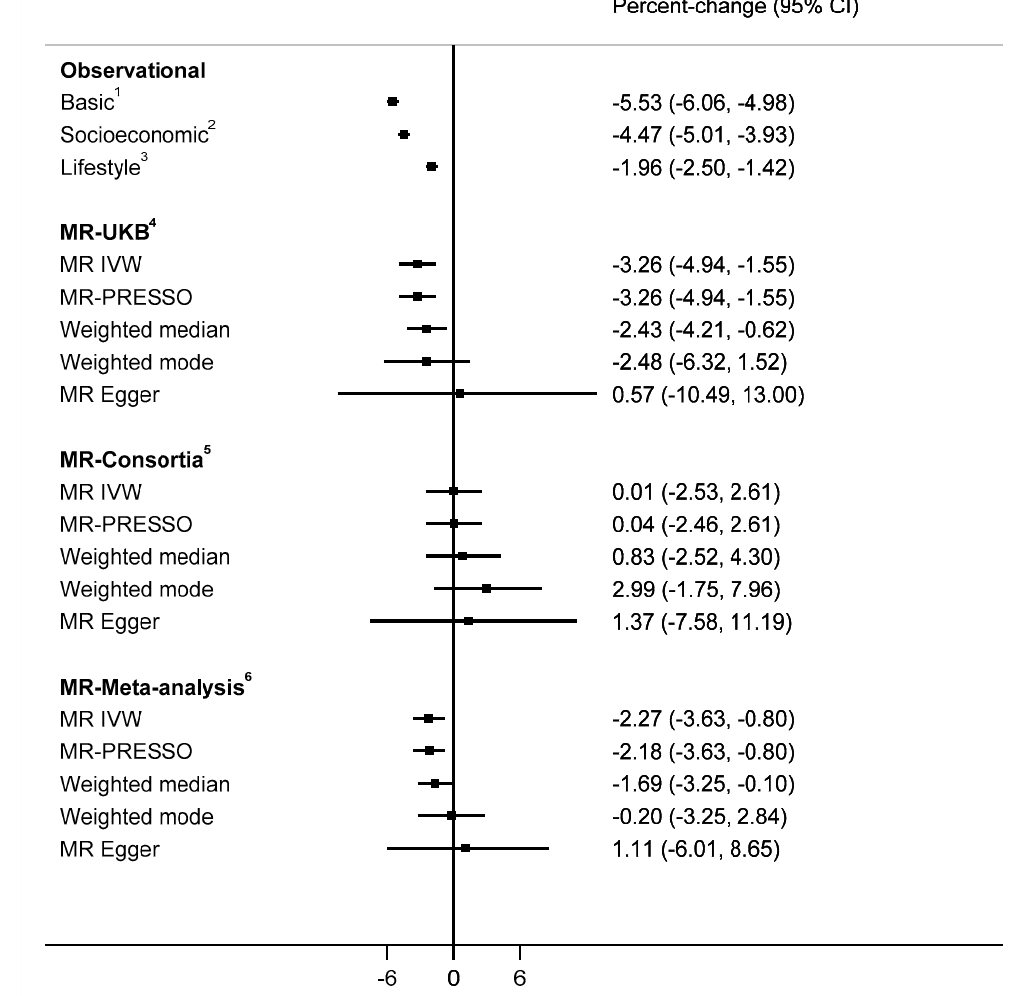
Figure 3. Observational and MR analyses on the association between depression and 25(OH)D concentrations. 1 Basic model included adjustment for basic covariates including age, sex, assessment centre and date of blood sample collected. 2 Socioeconomic model included adjustment for basic and socioeconomic-related covariates including education, Townsend deprivation index and employment. 3 Lifestyle model included adjustment for basic, socioeconomic and lifestyle-related covariates including smoking, alcohol consumption, BMI, physical activity, fish and cheese consumptions, dietary restriction, sun exposure [in summer or winter], use of sun protection and long-standing illness. 4 MR analysis based on variant-25(OH) association estimates from UK Biobank. 5 MR-analysis based on variant-25(OH)D association estimates from Jiang et al. GWAS. 6 Meta-analysis of MR estimates from UK Biobank and Jiang et al. GWAS. For all MR analysis, variant-depression estimates were from Wray et al. GWAS. MR-Egger P-intercept (for all), p <